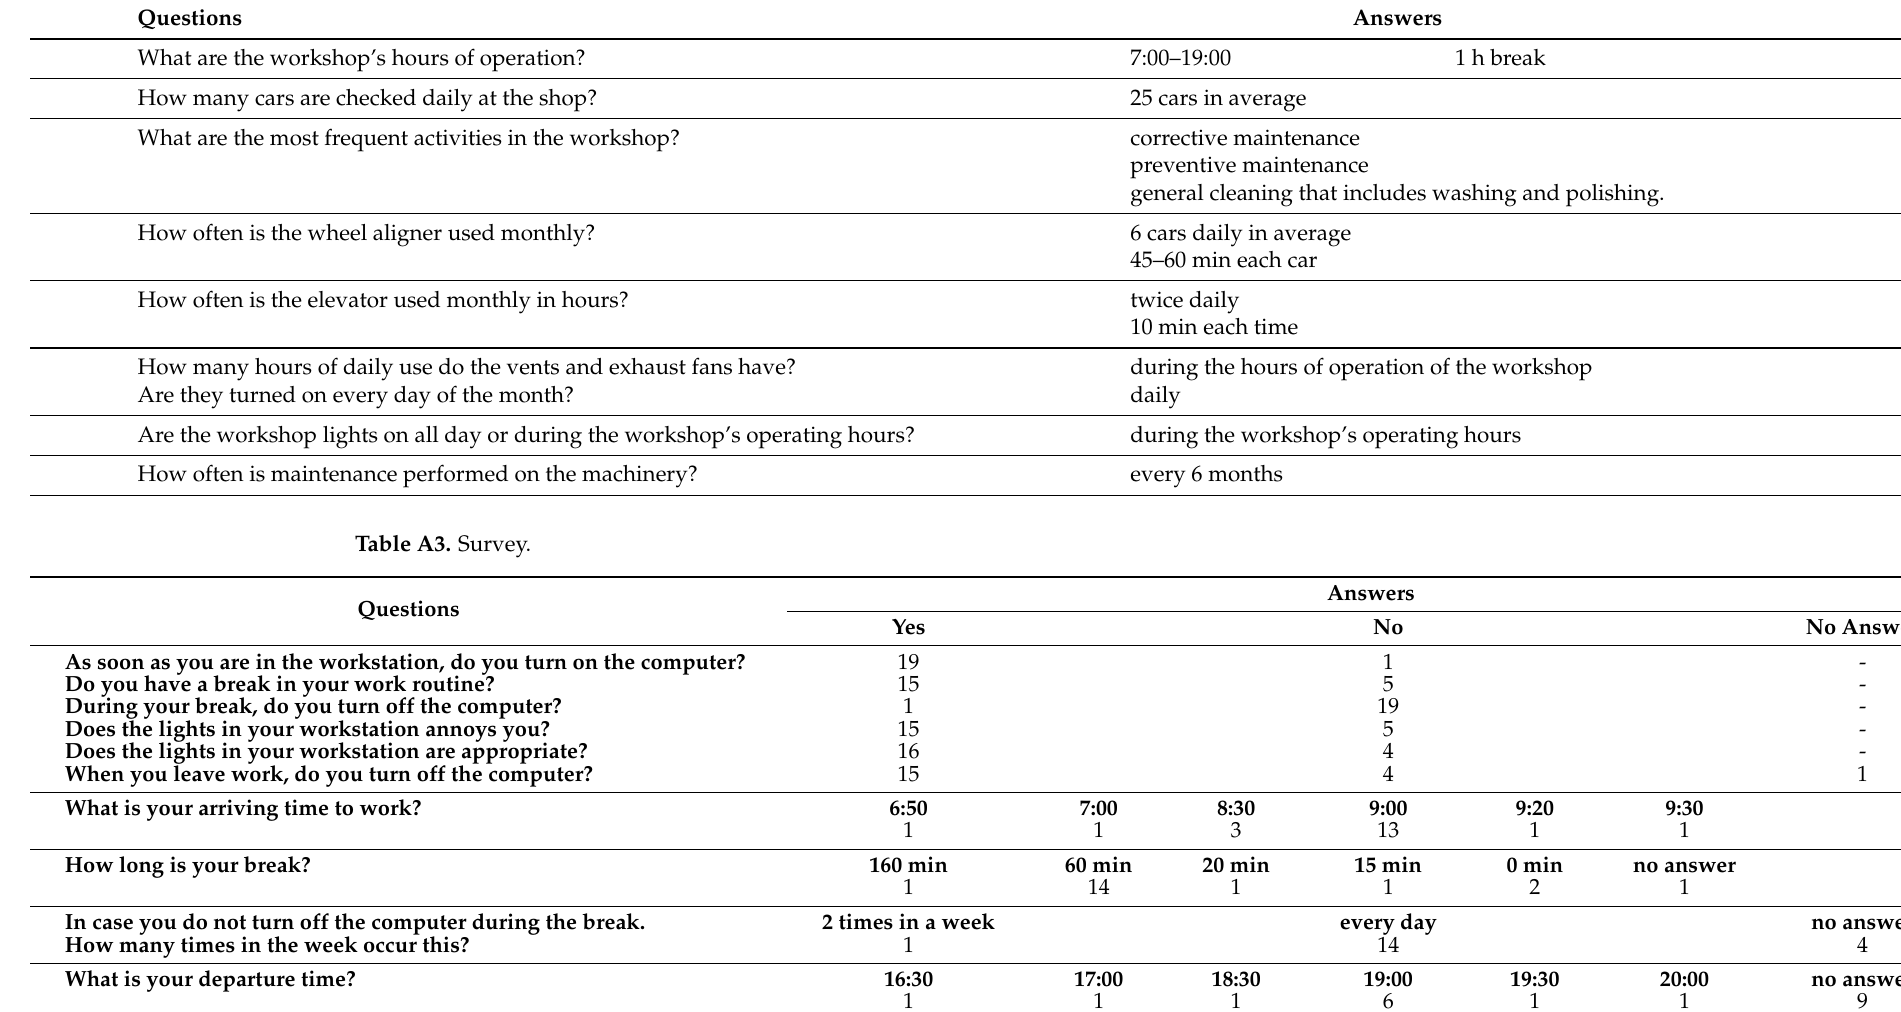
Table A2. Interview with workshop leader.